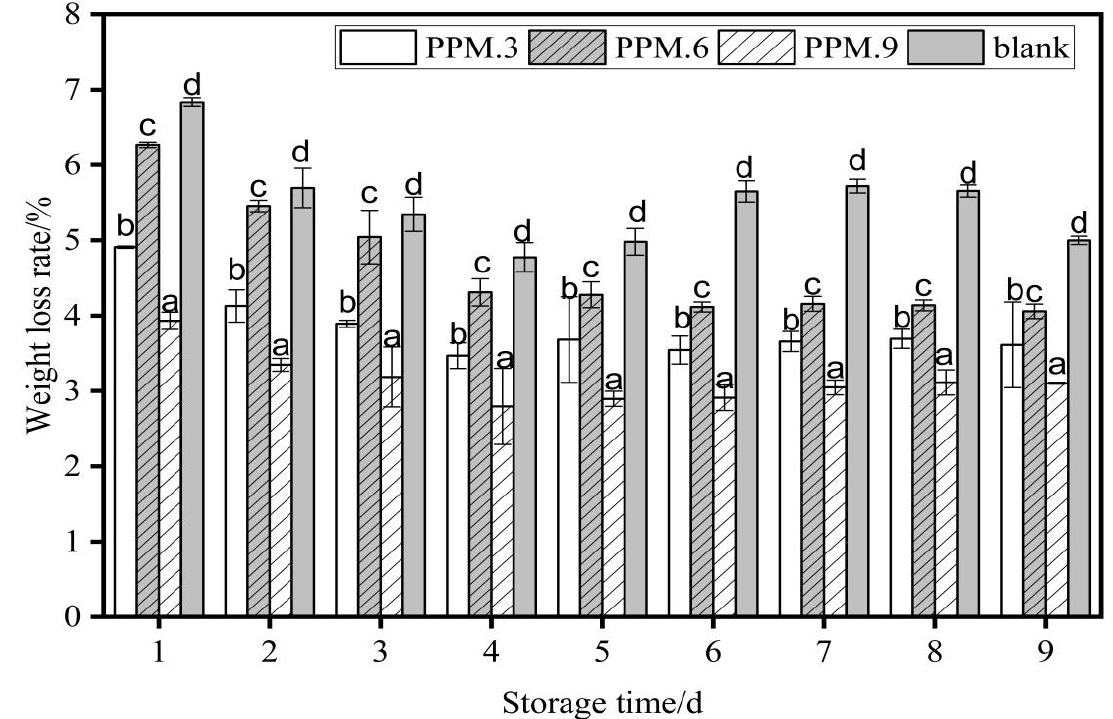
Figure 11. The effect of antioxidant film of each component content on the weight loss rate of strawberry ( p < 0.05). Data are presented as mean ± standard deviation, and different letters ( a – d ) within the columns show the significant differences (p < 0. 05), where is the lowest value.